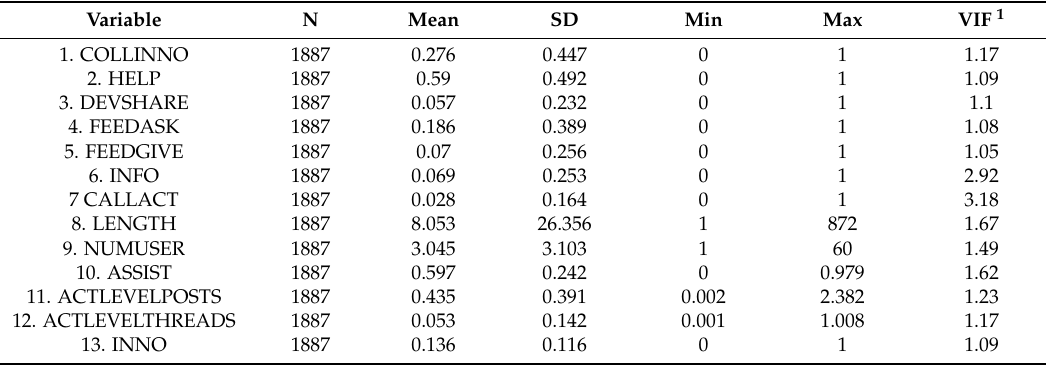
Table 2. Descriptive statistics and variance inflation factors